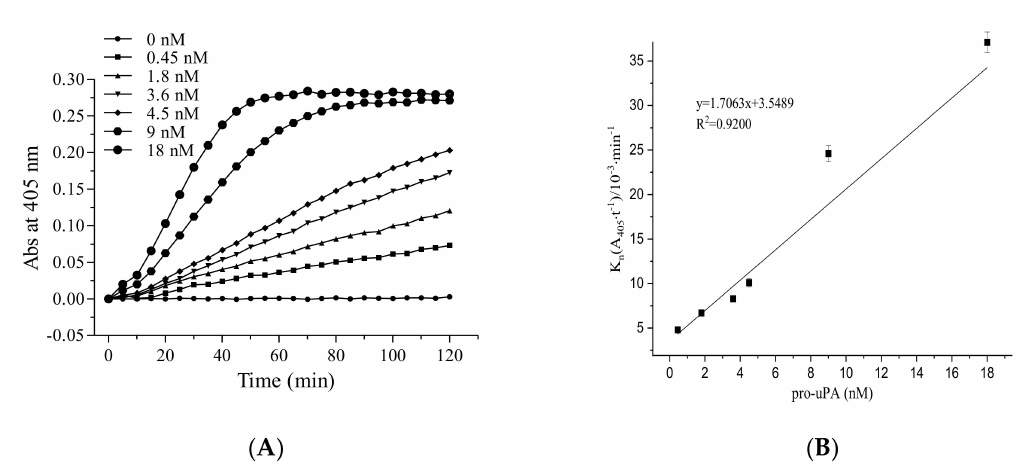
Figure 1. The role of the single-chain urokinase-type plasminogen activator (pro-uPA) in the fibrinolytic activity of fungi fibrinolytic compound 1 (FGFC1). Plot of absorbance at 405 nm (A405) versus time ( A ) and the values of K n ( B ) at different pro-uPA concentrations (0–18 nM). The reaction was incubated at 37 ◦ C and measured every 5 min for 120 min. The results are expressed as the mean ± SD performed in triplicate. The concentration of Glu-plasminogen and FGFC1 in the reaction system were 40 nM and 0.048 mM, respectively.